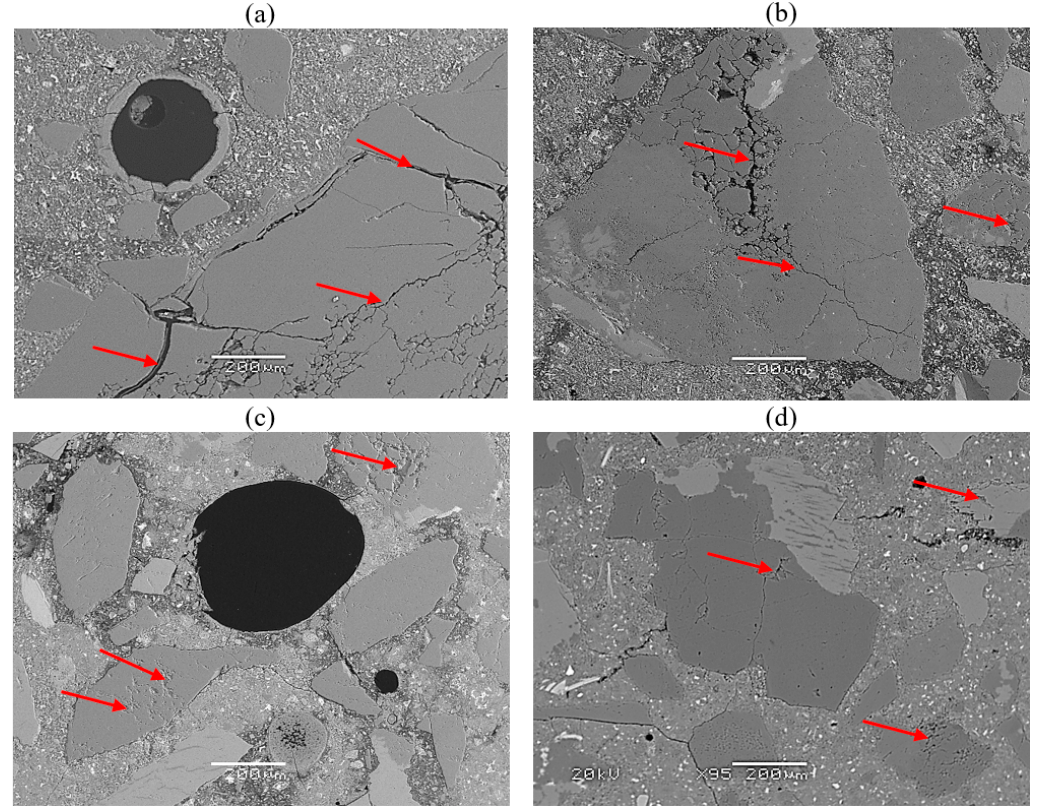
Figure 3. Dependency of the degree of cracking of the aggregate on the replacement level of cement with calcined clay: ( a ) 0%, ( b ) 10%, ( c ) 20% and ( d ) 30%; SEM-BES, scale bar = 200 µm.